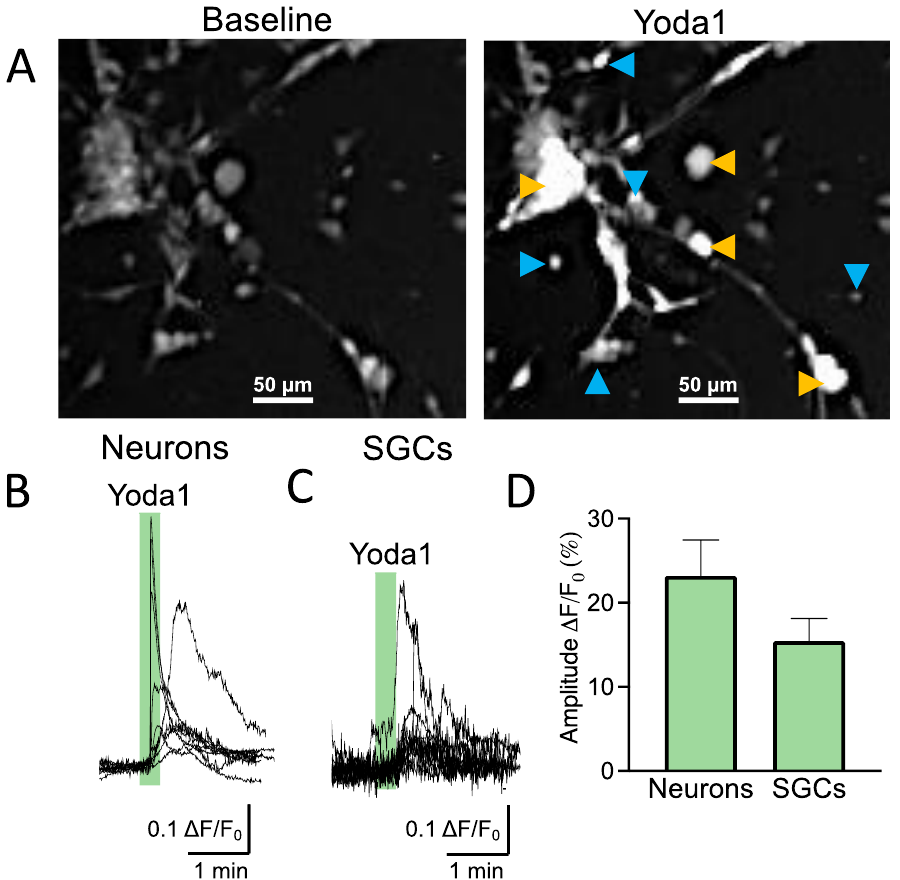
Figure 1. Live imaging shows that Piezo1 channels are functionally expressed on SGCs and neurons. ( A ). Fluorescent snapshots of 2DIV mouse trigeminal culture showing SGCs (blue arrows) and neurons (yellow arrows). The snapshots have been taken after 20 min of incubation with Fluo-4 AM. The left frame represents the trigeminal culture during baseline. The right frame shows cell activation after the application of 5 µ M of Yoda1. Scale bar—50 µ m. ( B ). Sample traces of calcium transients in trigeminal neurons induced by 5 µ M of Yoda1 ( n = 9). ( C ). Sample traces of calcium transients in trigeminal SGCs induced by 5 µ M of Yoda1 ( n = 12). ( D ). Statistics of the percentage of increased fluorescence intensity normalized to baseline in neurons ( n = 9) vs. SGCs ( n = 12) treated with 5 µ M of Yoda1. There is no difference in Yoda1 responses among the different cell types (unpaired t -test, p = 0.120).